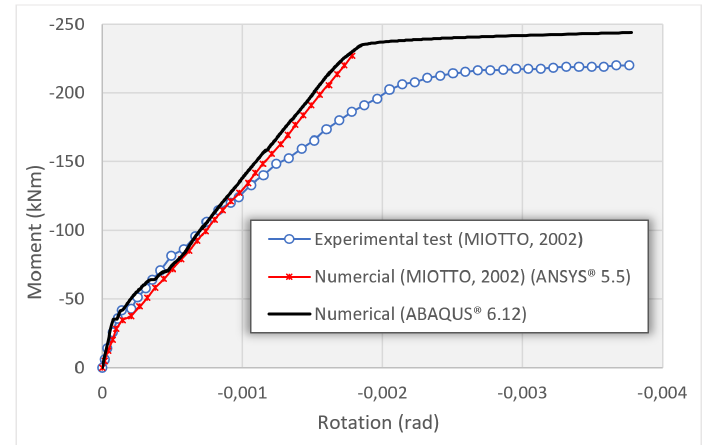
Figure 8. Moment-rotation curve of calibration model (Adapted from Miotto [8]).